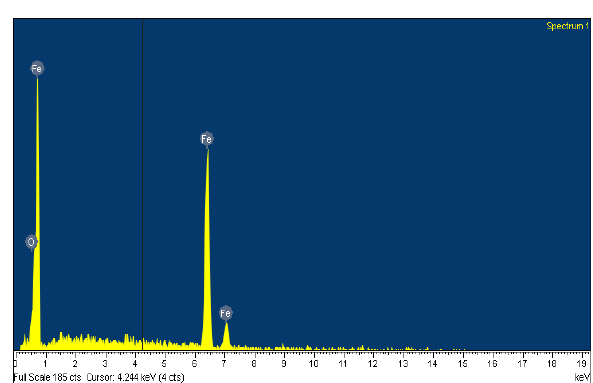
Figure 3. The EDS spectrum of material Fe.